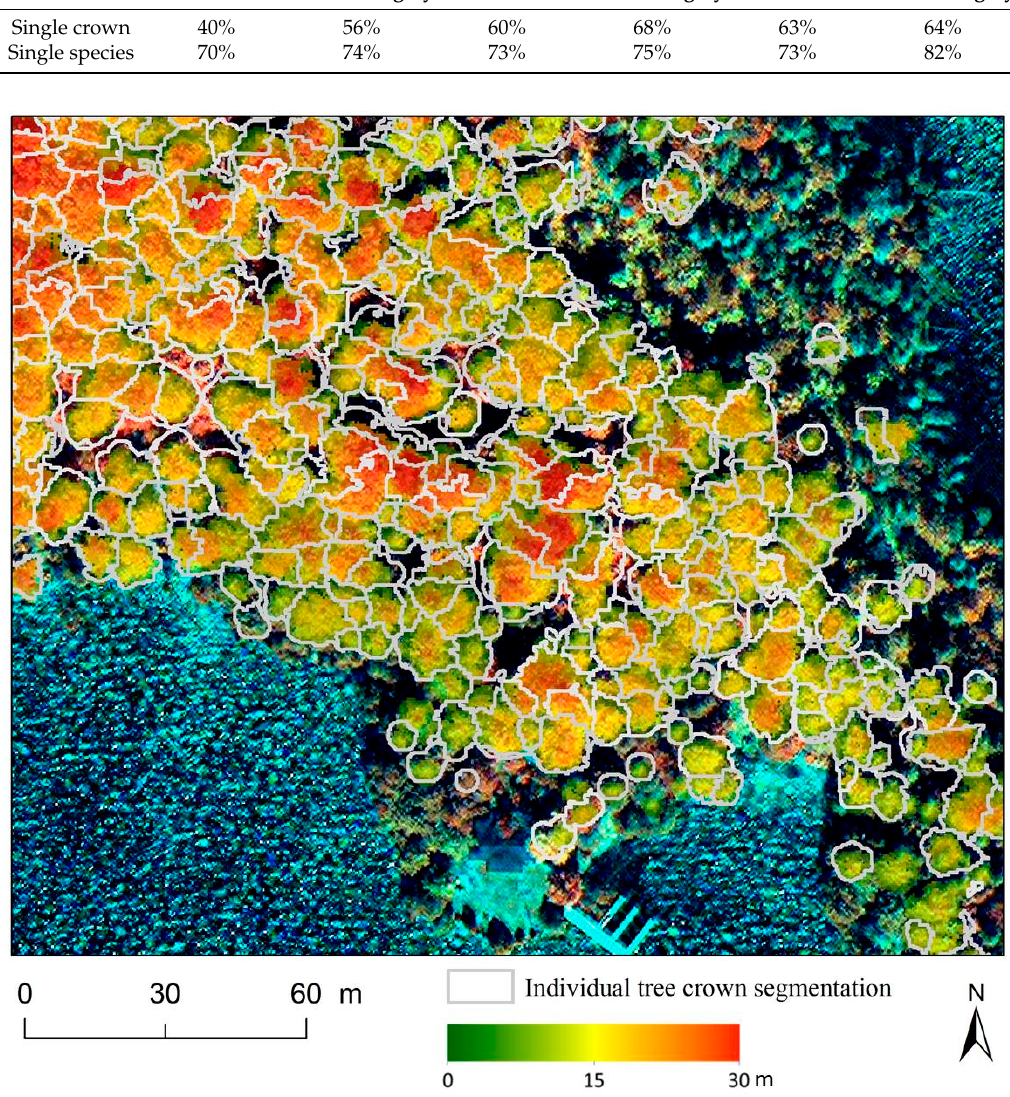
Figure 4. Individual tree crown segmentation based on LiDAR (canopy height model) and WorldView-3 imagery. The background image displays WorldView-3 in true colors.